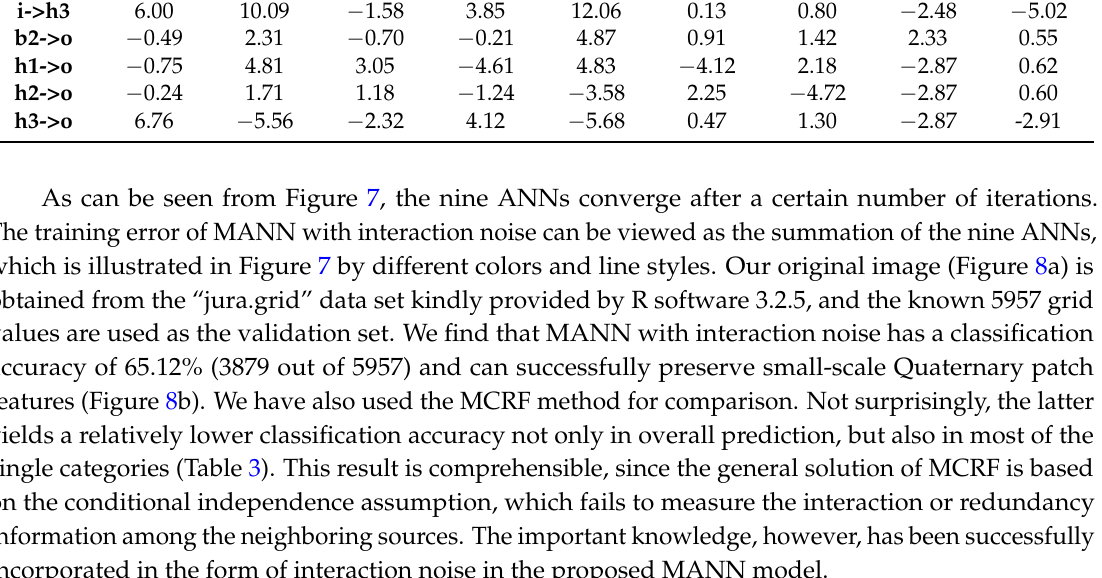
Table 2. Training weights of MANN with interaction noise. Input node, hidden nodes and output node are represented by i, h1 to h3 and o, respectively; b1 and b2 are the bias nodes in the hidden layers.